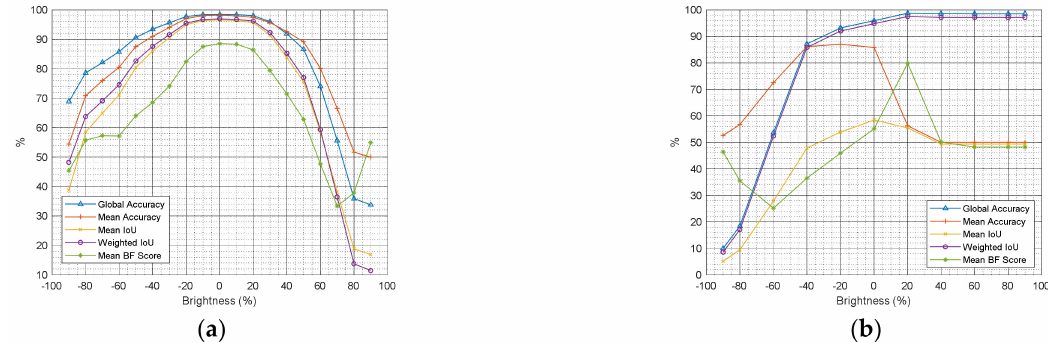
Figure 16. The effect of brightness on the accuracy of bridge component detection ( a ) and damage segmentation ( b